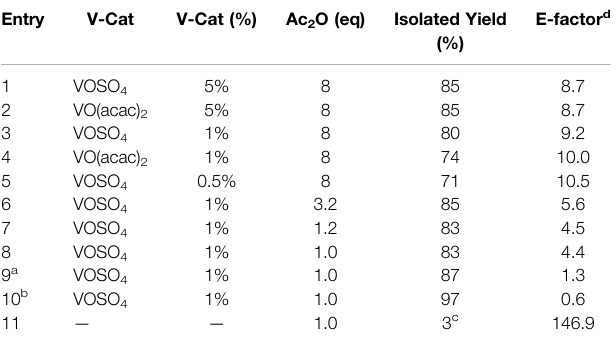
TABLE1| Thymolacetylation.Reactionconditions:thymol=6.7 mmol(1 g),T=r. t., and t = 24